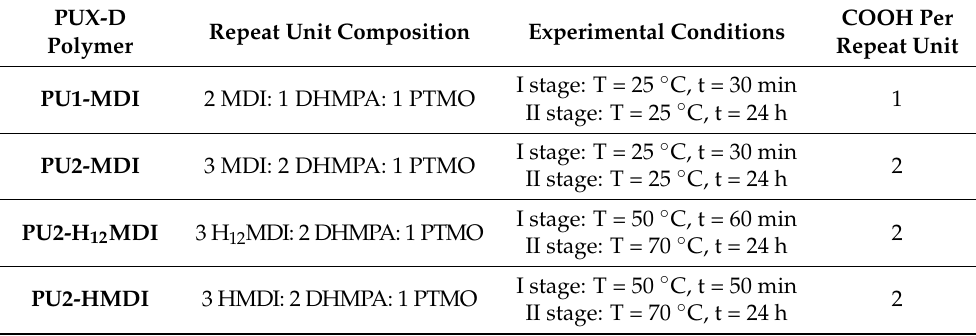
Table 1. Experimental conditions of polyurethanes’ synthesis, acronym and repeat unit composition of the synthesized polymers.